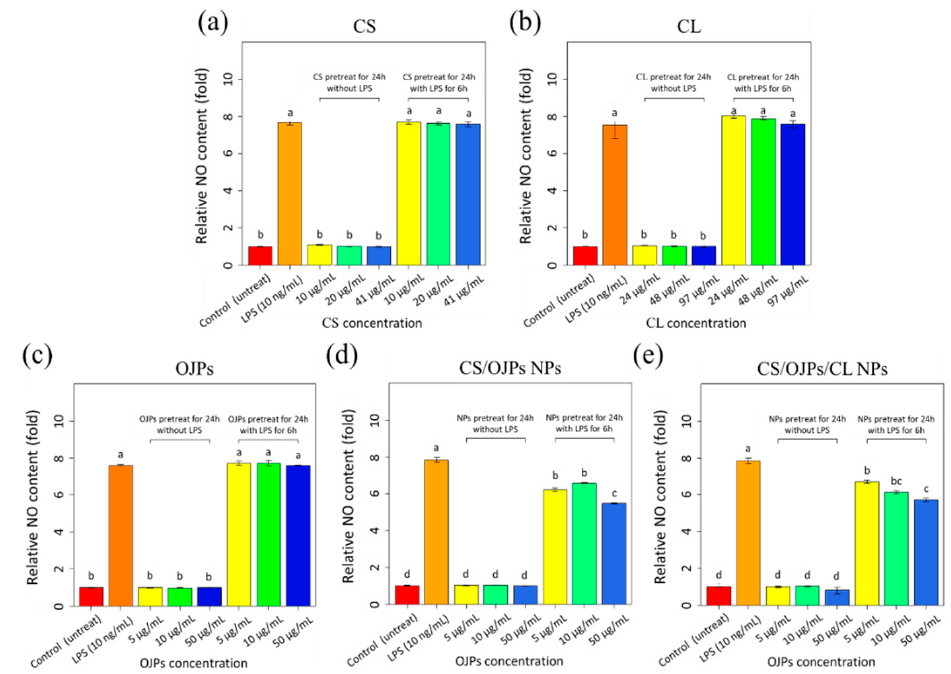
Figure 9. Inhibitory effect of CS/OJPs and CS/OJPs/CL NPs against LPS-induced NO production in RAW264.7 cells. Raw materials ( a – c ) and nanoparticles ( d , e ). The different lowercase letters represent statistically significant differences ( p < 0.05).